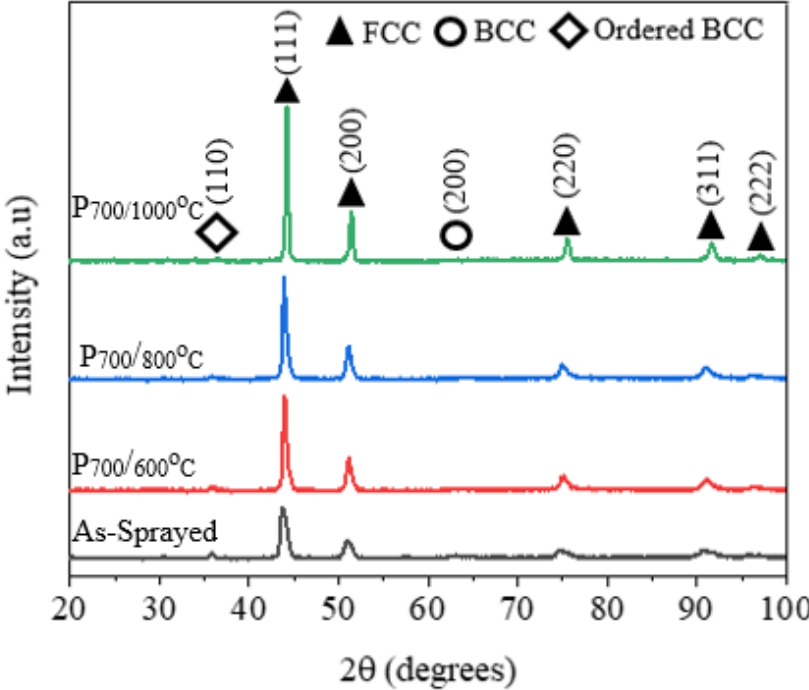
Figure 6. XRD spectrum of the heat ‐ treated coatings with a spraying power of P 700 .